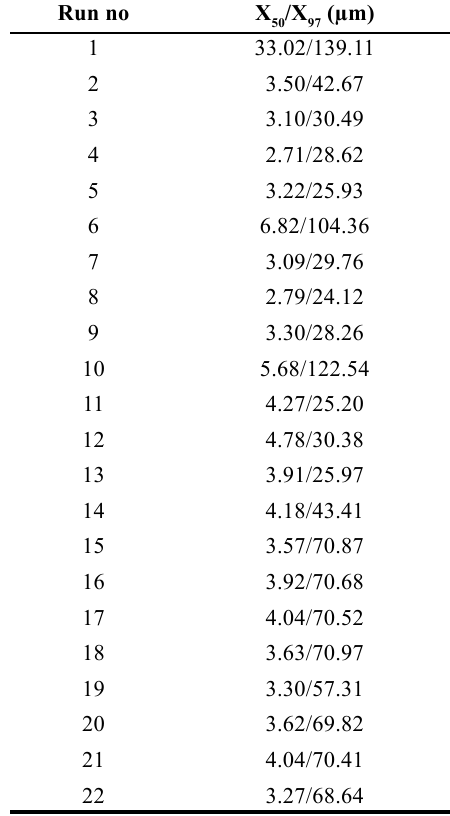
Table 5 . Particle size of the feed sample and